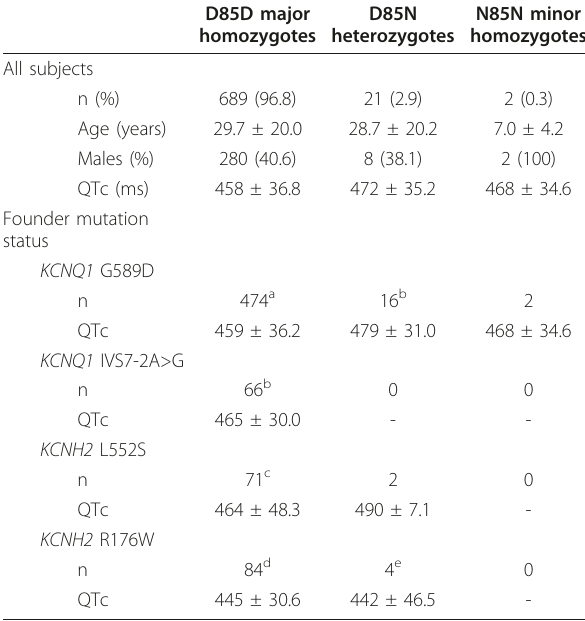
The figures represent the mean ± SD. SD, standard deviation; QTc, heart rate- corrected QT interval. a Four subjects carrying also KCNH2 R176W, one KCNH2 L552S, and one KCNQ1 Y171X. b One subject carrying also KCNH2 R176W. c Includes two KCNH2 L552S homozygotes and one subject carrying also KCNQ1 G589D. d Four subjects carrying also KCNQ1 G589D and one KCNQ1 IVS7-2A>G. e One subject carrying also KCNQ1